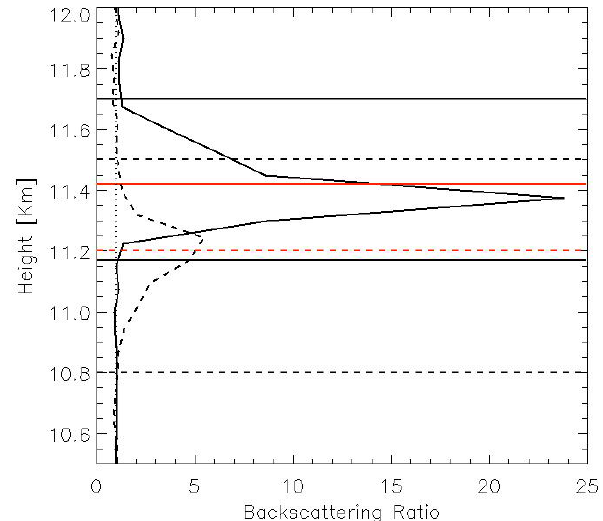
Fig. 5. Backscattering ratio profiles of the cirrus measured at OHP for the first quasi-stationary period (18:48–19:20UTC, continuous line) and at RTV for the last quasi-stationary period (23:37–00:50, dashed line). Horizontal black lines identify the cirrus top and base heights, while the red lines indicate cirrus